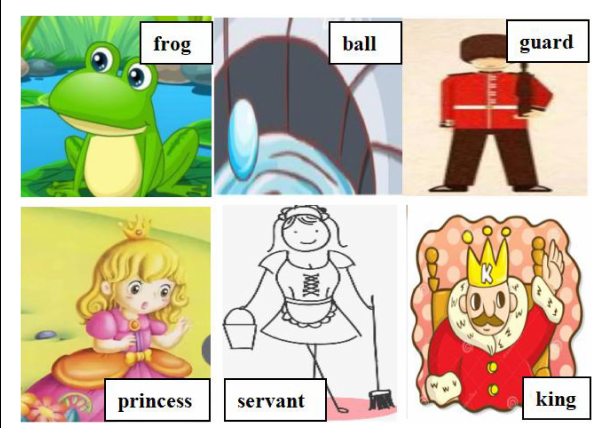
FIGURE 1 | Layout of functional character